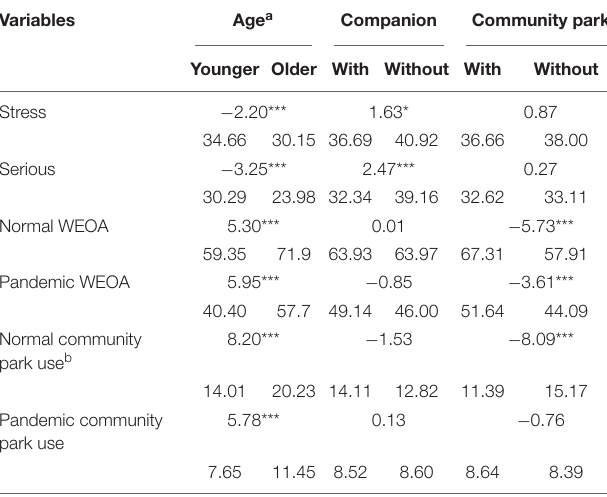
TABLE 4 | Two sample t -test of different social demographic